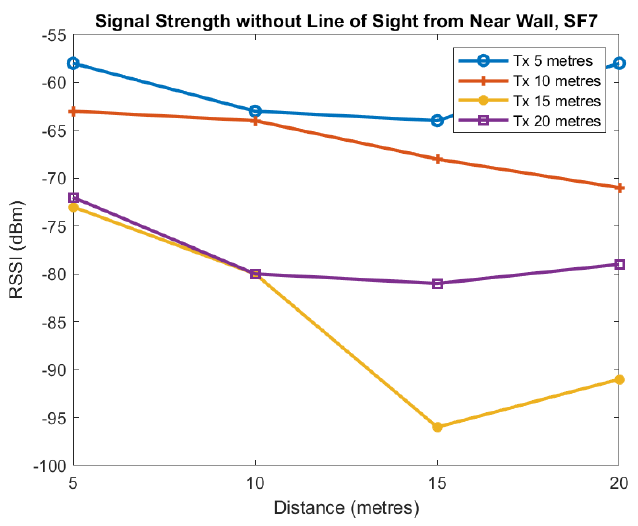
Figure 17. RSSI against receiver distance from junction for different transmitter distances from junction, Near-Wall,